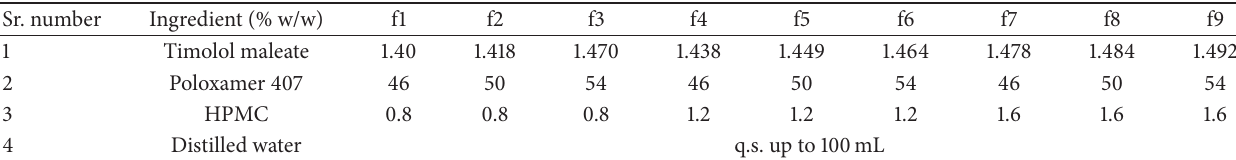
Table 3: Formulation of factorial